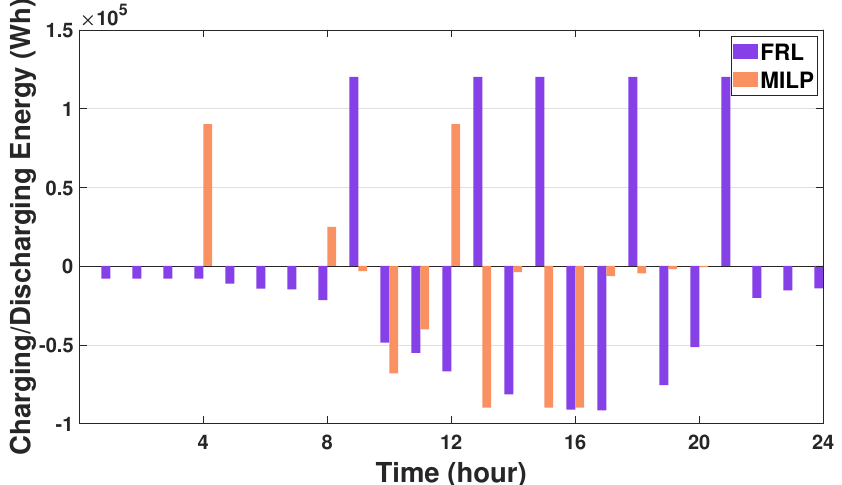
Figure 12. Comparison of hourly charging and discharging energy ( E SESS proposed FRL method and the mixed-integer linear programming (MILP)